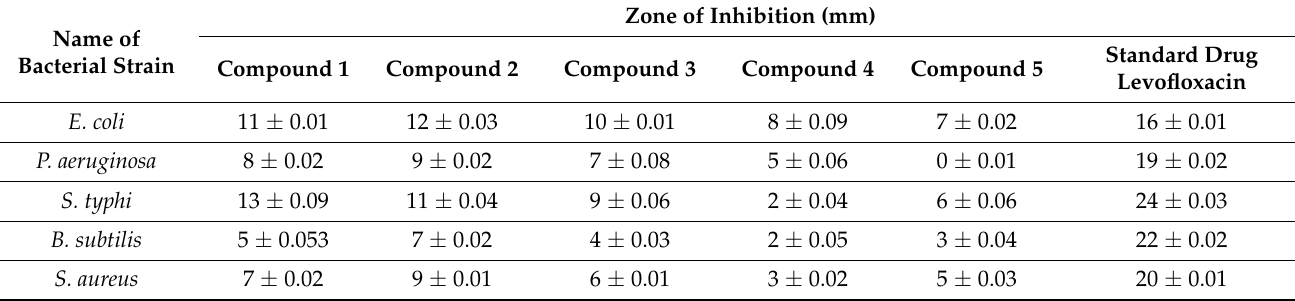
Table 4. Antibacterial activities of compounds 1 – 5 (30 µ g/mL) against different bacteria